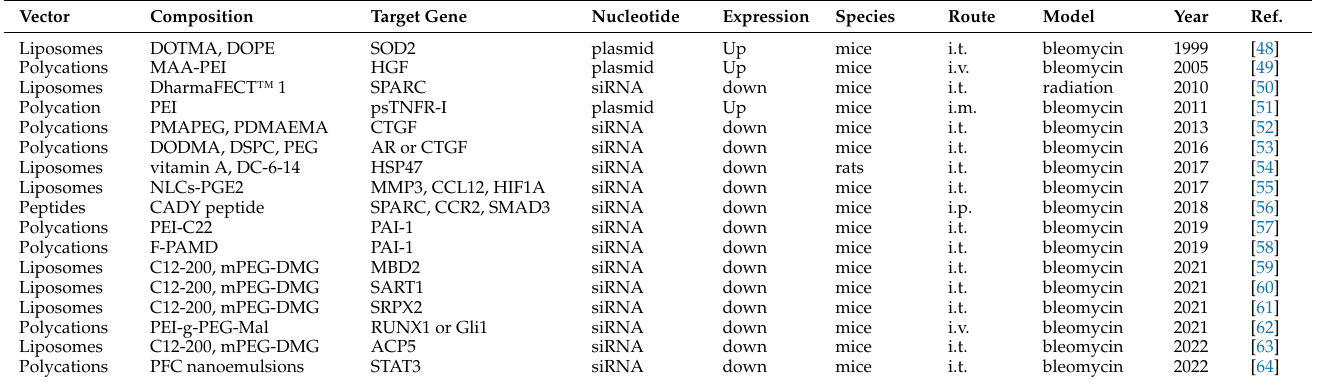
Table 1. Publications on non-viral gene vectors for pulmonary